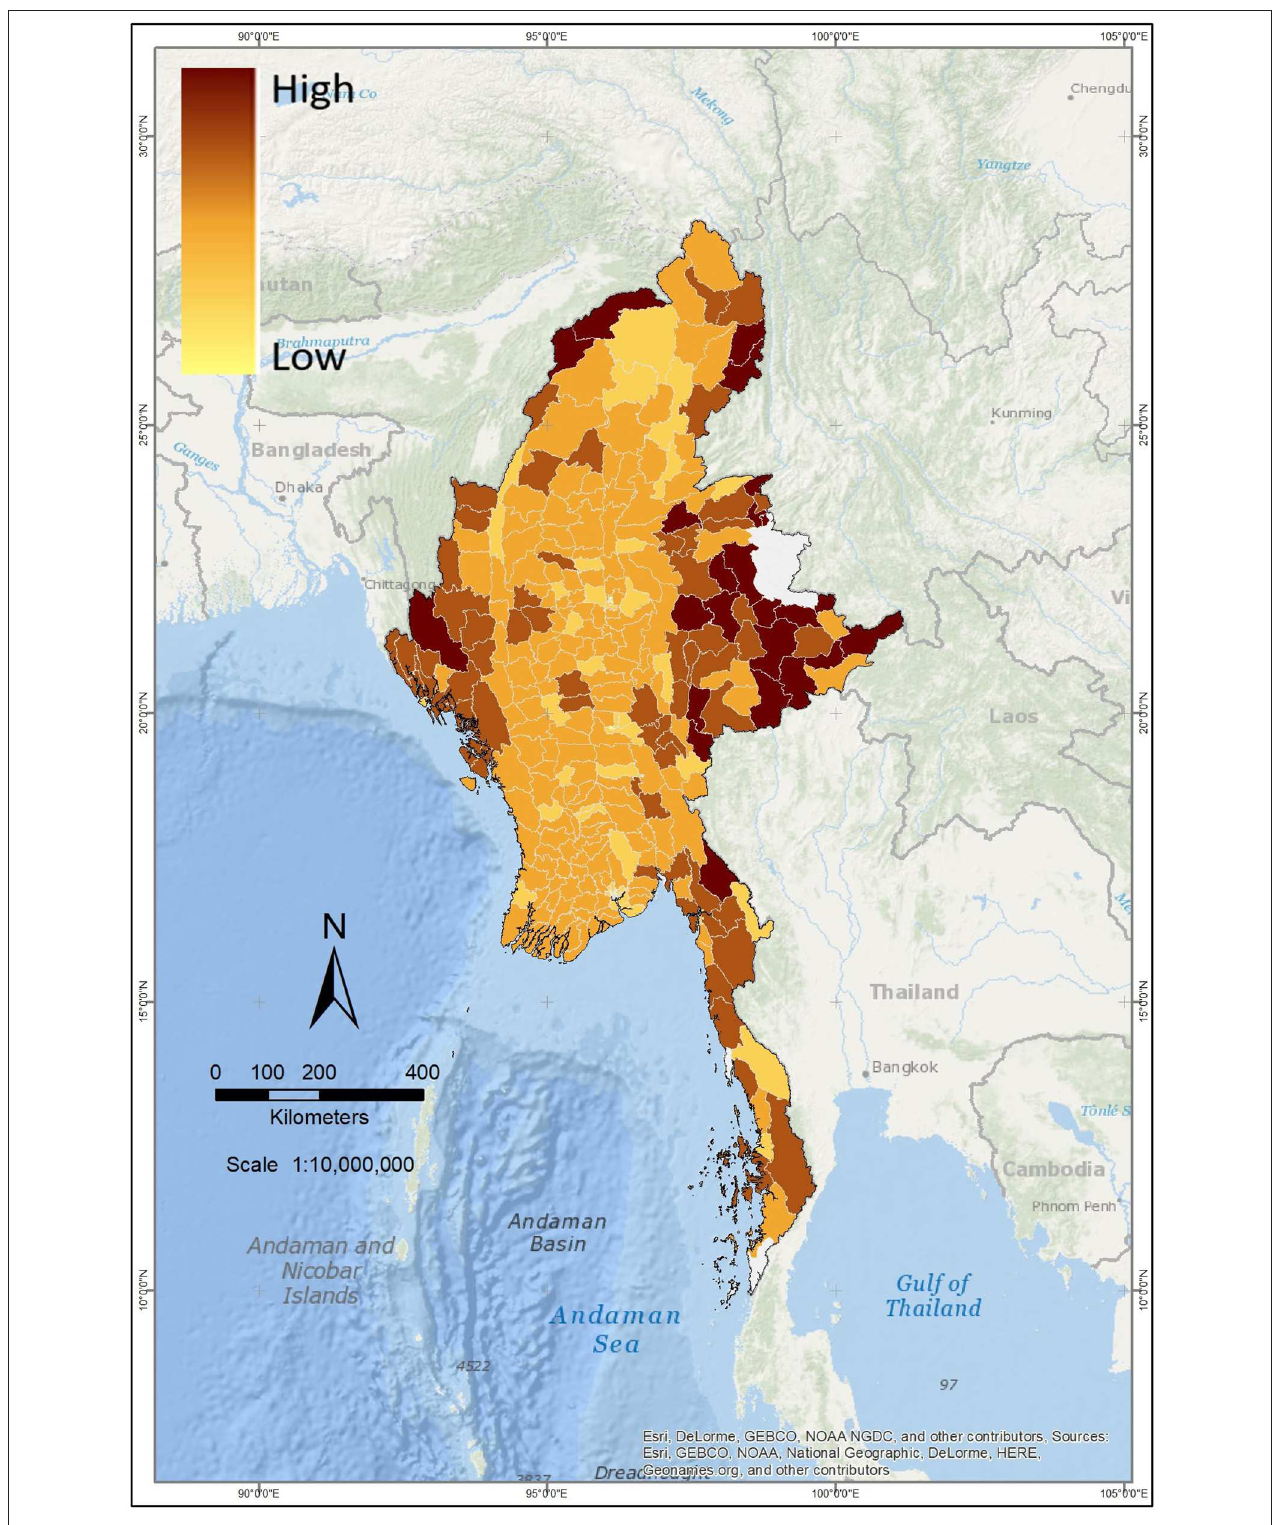
FIGURE 7 | Flood vulnerability on a township level for Myanmar. Vulnerability was calculated from literacy, population composition, and urbanization.